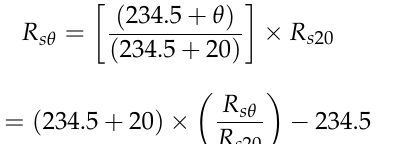
Figure 29. Comparison of measurement and calculation results of air friction loss at different rota ‐ tional speeds.